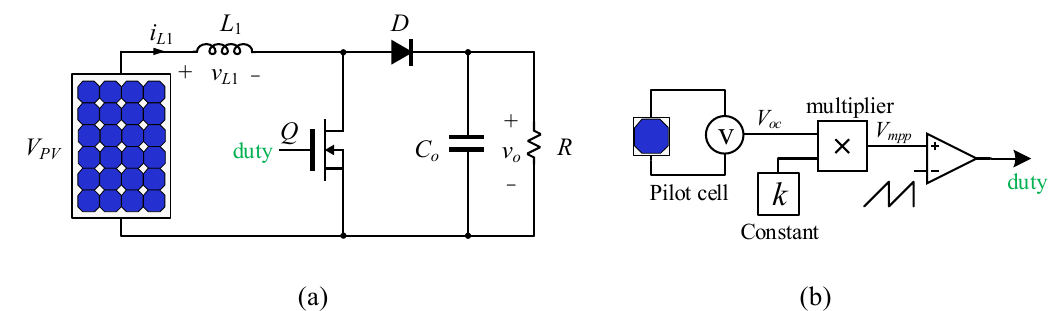
Figure 6. An example of how FOCV with the pilot cell is implemented: ( a ) the PV is connected to a conventional boost converter, which is controlled by the duty cycle ( b ) the pilot cell provides the reading of the V OC to the control circuit.